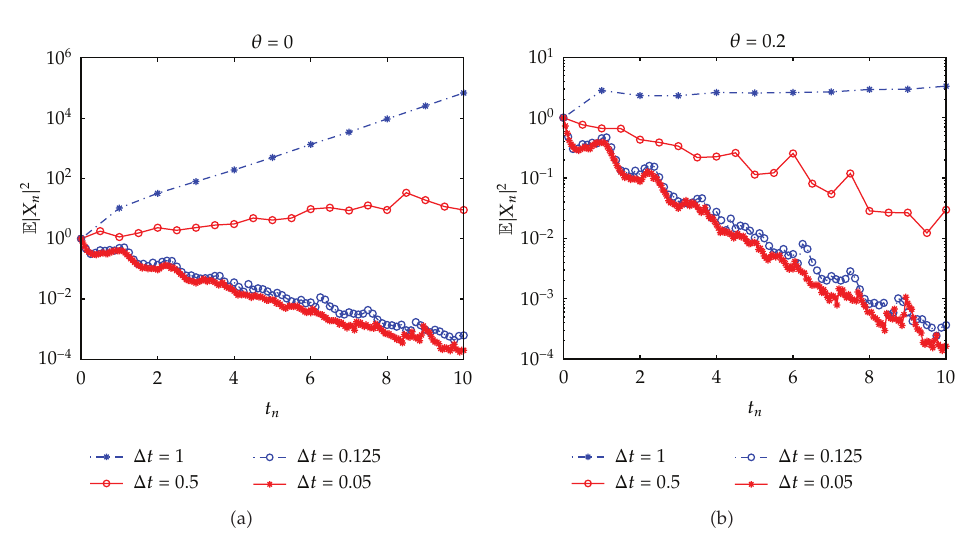
Figure 2: Fixed θ (cid:7) 0 (cid:3) a (cid:4) and θ (cid:7) 0 . 2 (cid:3) b (cid:4) with di ff erent stepsize Δ t (cid:7) 1 / 20 , 1 / 8 , 1 / 2 ,